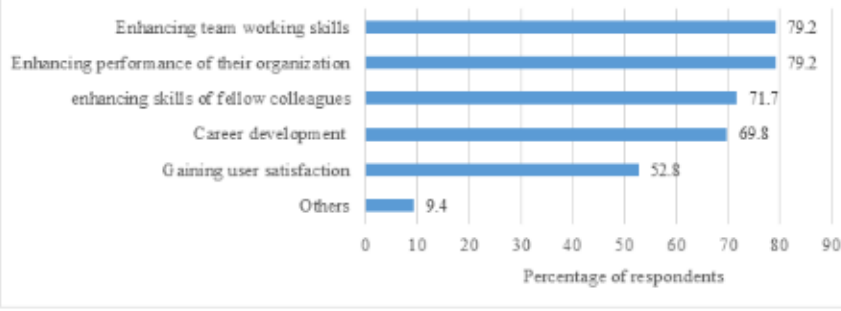
Figure 4 Barriers to knowledge sharing among health sciences librarians in